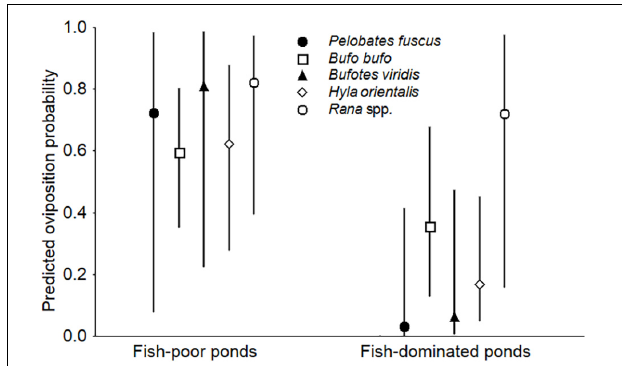
FIGURE 1 | Mean proportional occurrence of anuran taxa in fish-poor and fish-dominated ponds (proportion of ponds with taxon present). Symbols and error bars represent back-calculated means and ± 95% confidence intervals, respectively, from binomial GLMM.